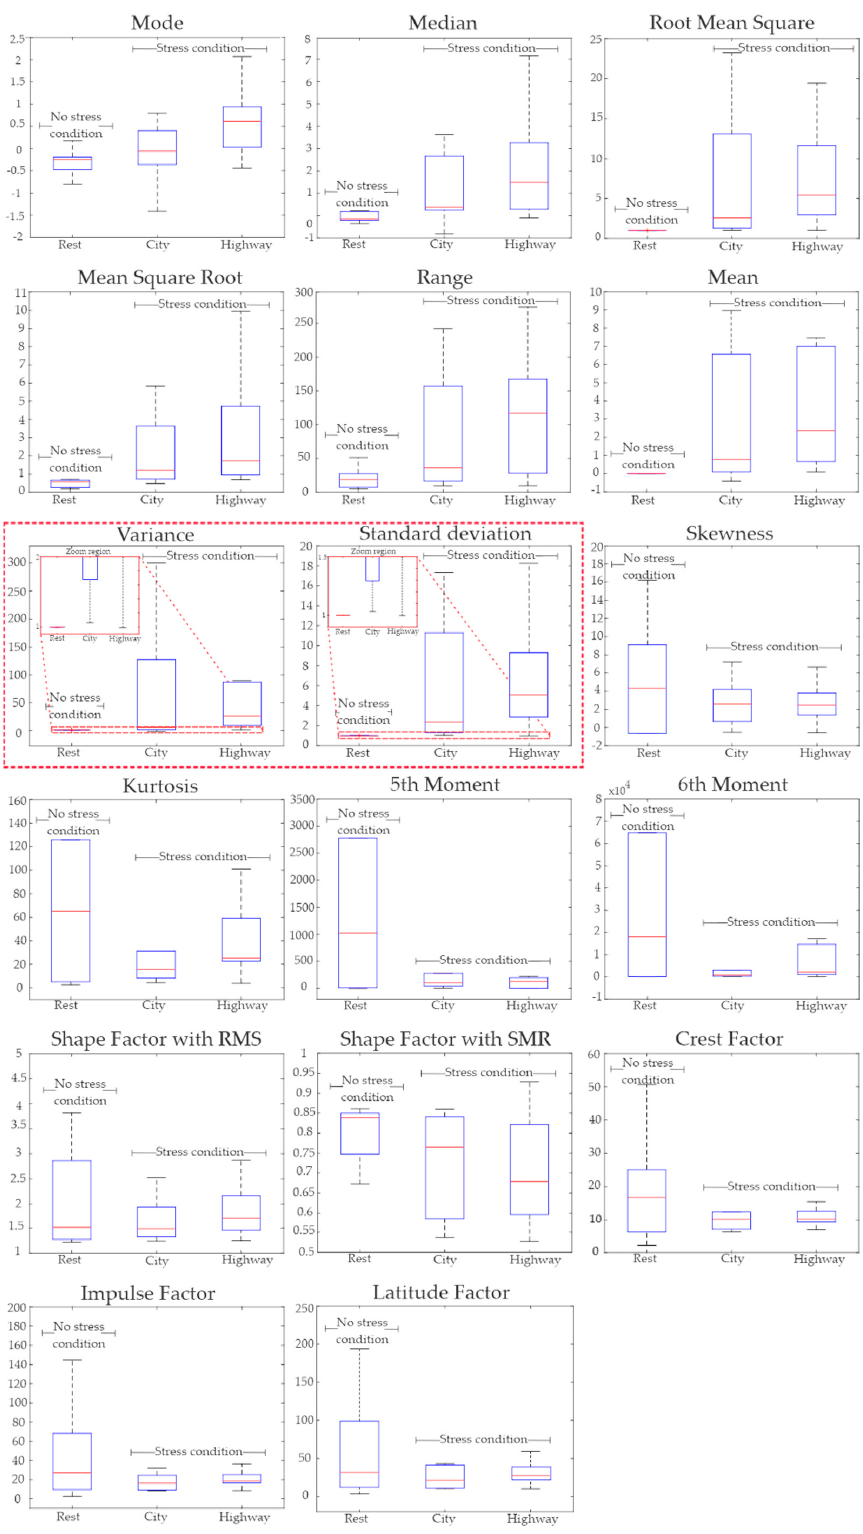
Figure 7. Box diagrams of the 17 STFs of the three periods with the normalized segments.